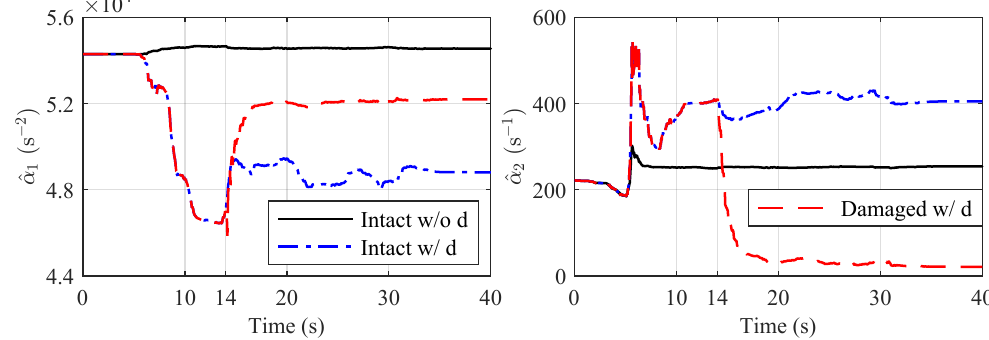
Figure 17. Parameter estimations for Intact w/o d, Intact w/ d and Damaged w/d (El Centro earthquake, Case 4, perturbed